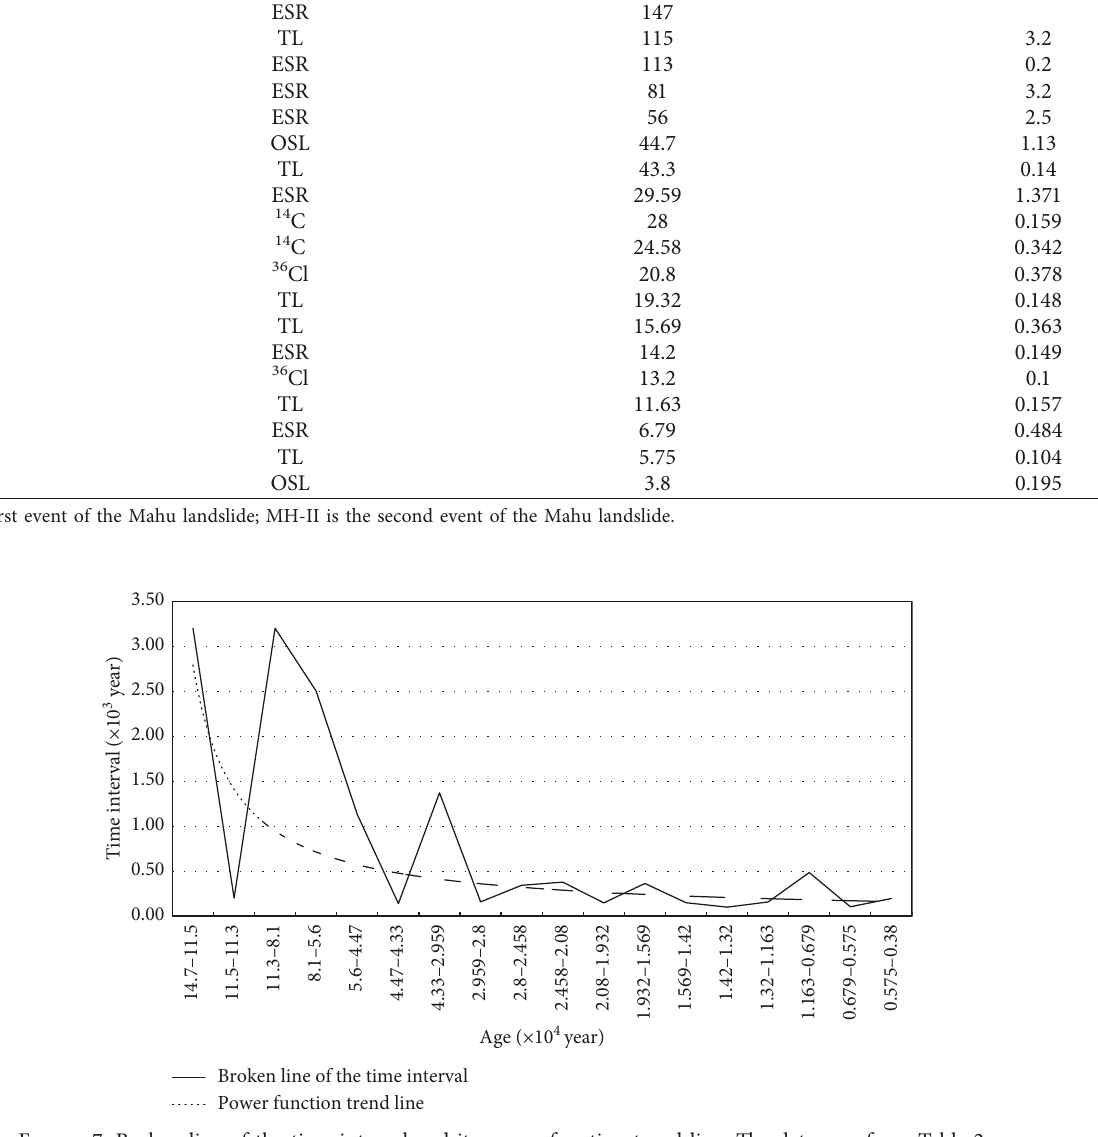
Figure 7: Broken line of the time interval and its power function trend line. The dates are from Table